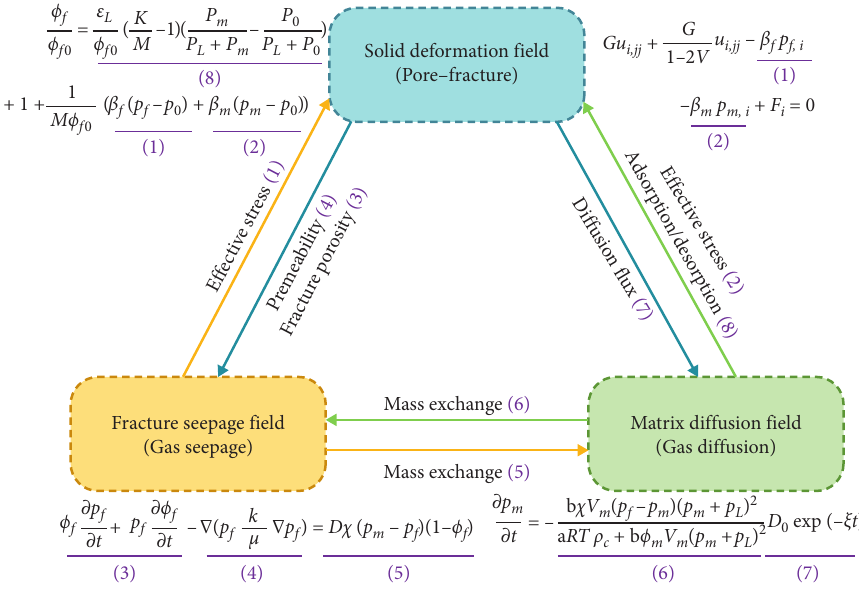
Figure 1: Schematic diagram of physics coupling